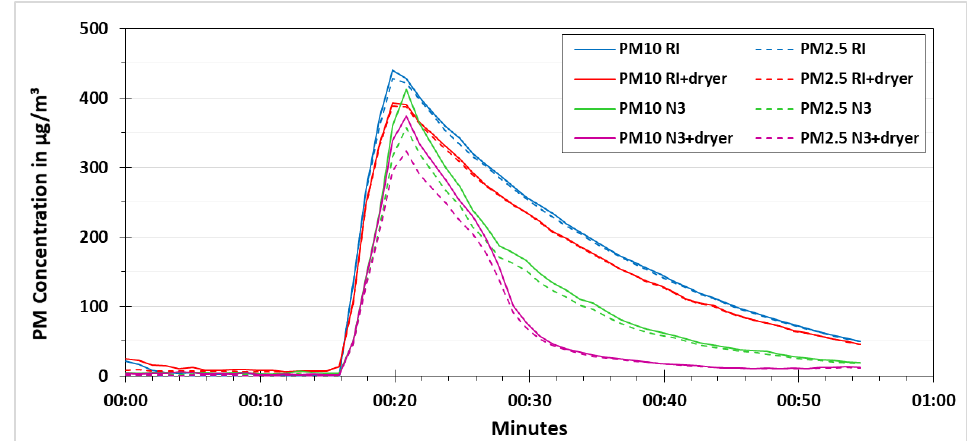
Figure 10. PM concentration comparison for testing the low-cost dryer at an applied voltage of 7 V.